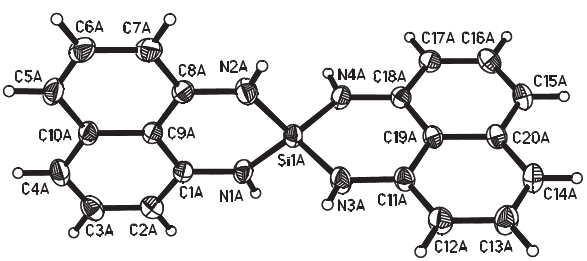
Figure 7: Molecular structure of 5b including numbering scheme.